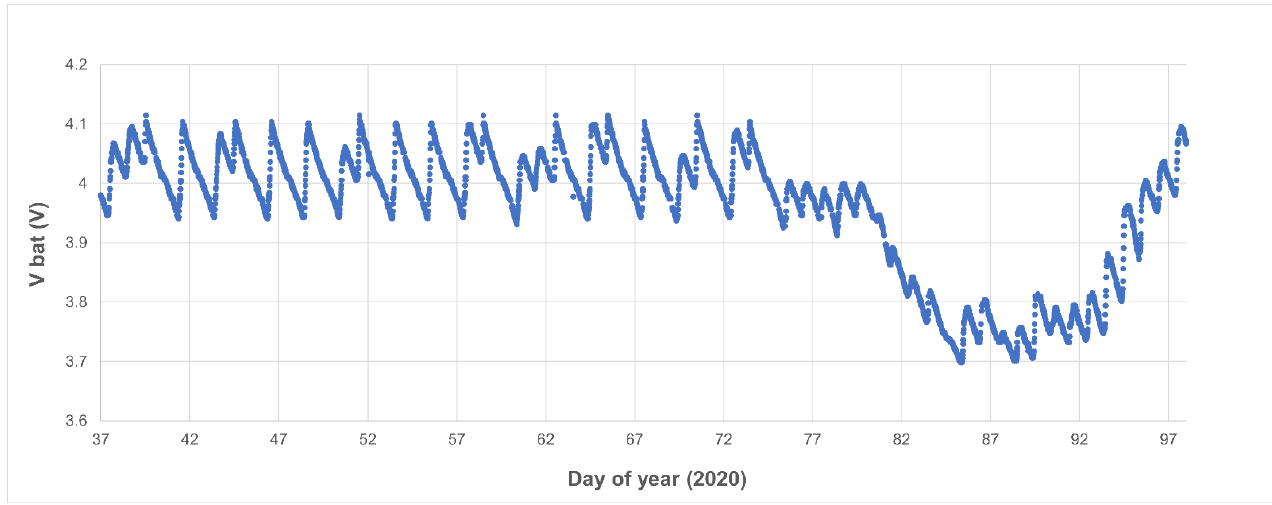
Figure 17. Evolution of the battery voltage of a node with a dirty panel (node 05).